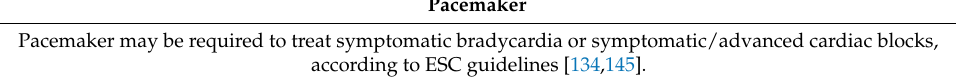
Table 7. Cont. Recommendations for the Supportive Treatment of Cardiac Manifestations in FD